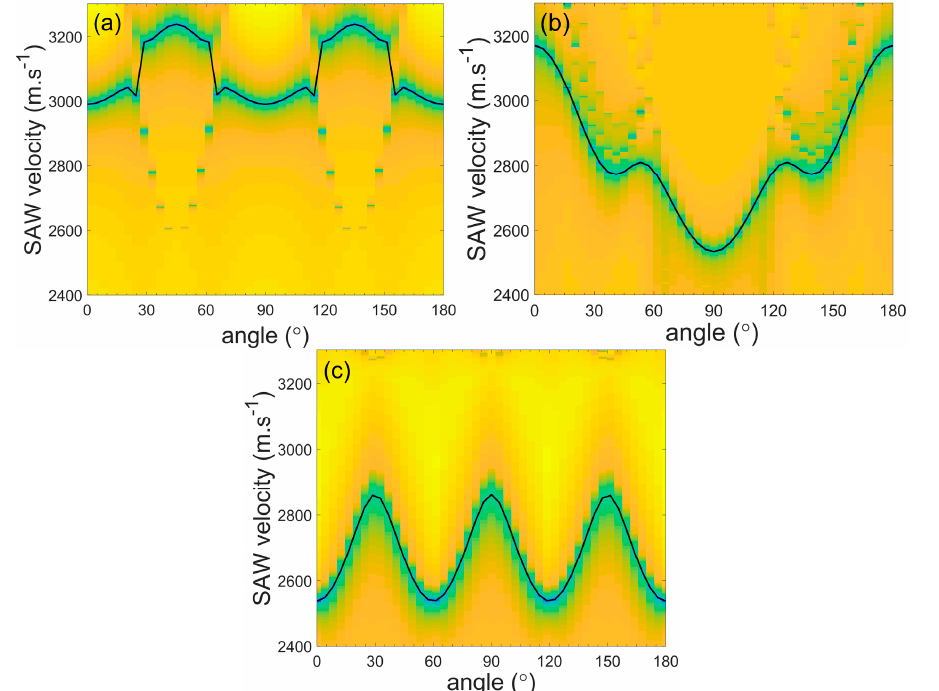
Figure 6. Simulated angular dispersion of SAW velocity in a single crystal of interstitial free (IF) steel: ( a ) (100) plane; ( b ) (110) plane; ( c ) (111) plane.